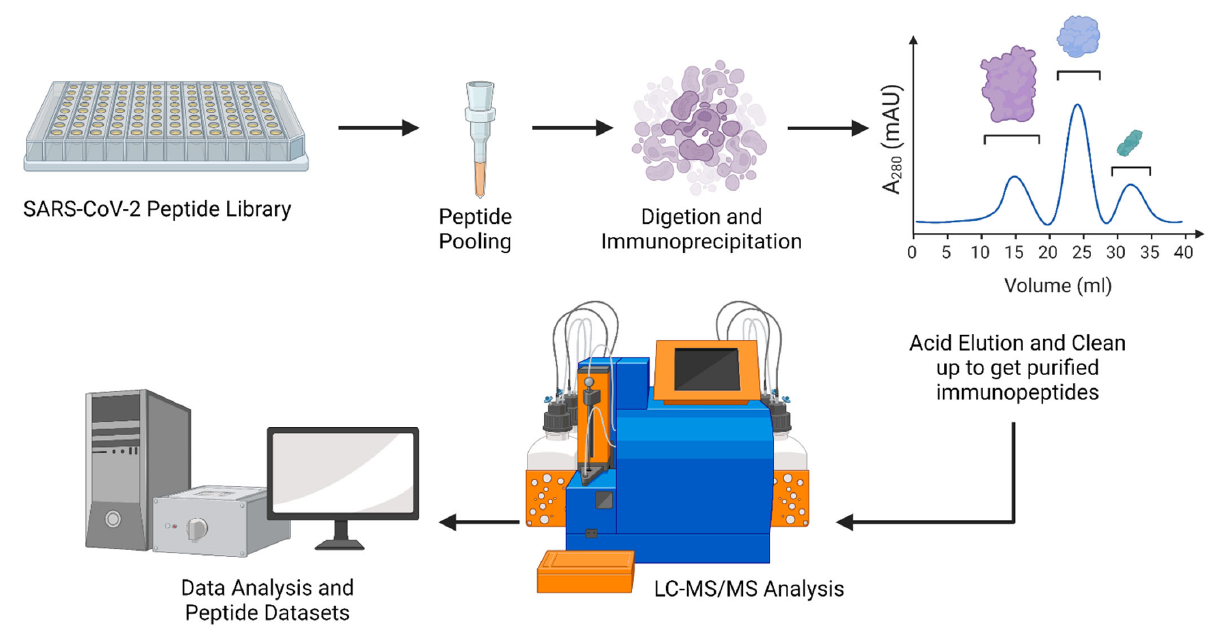
Figure 1. Overview of the immunepeptidomics screenings for COVID-19 (created with Biorender.com (access on 18 November 2022)).